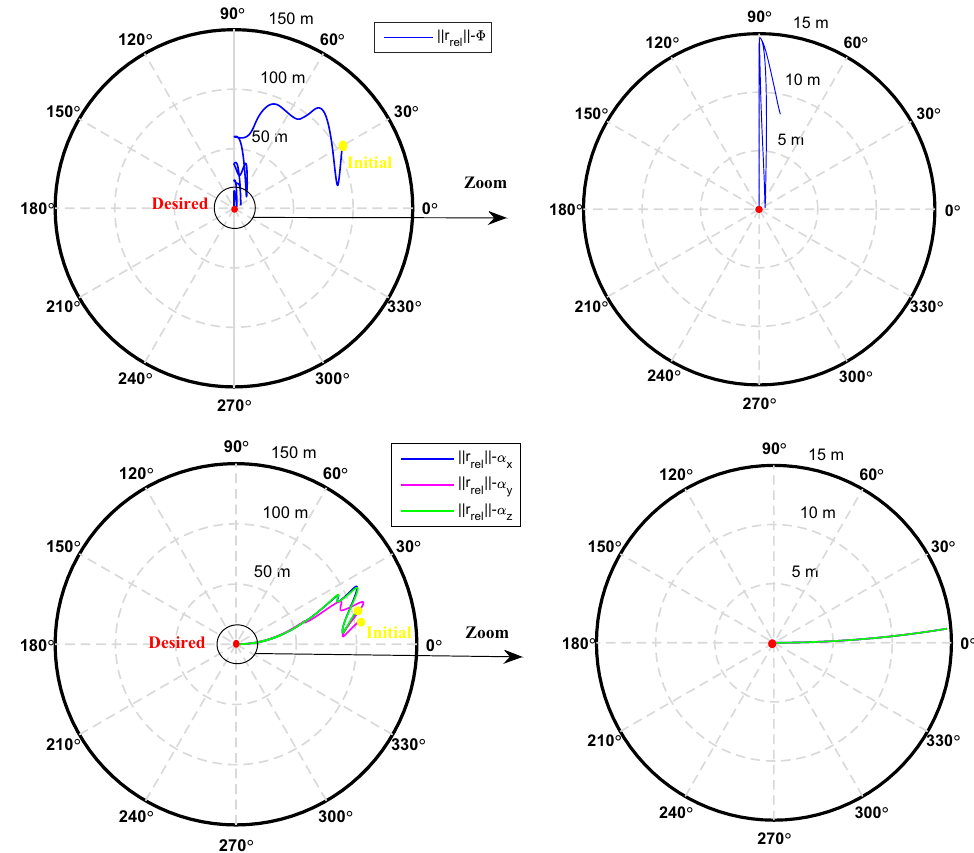
Figure 32. Relative pose trajectory in polar coordinate (Scenario